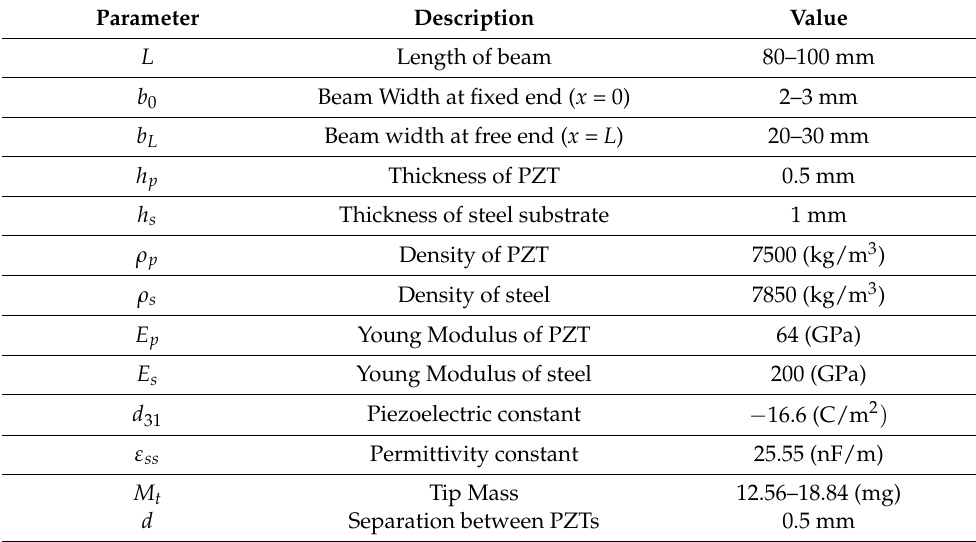
Table 1. Geometric dimension and material